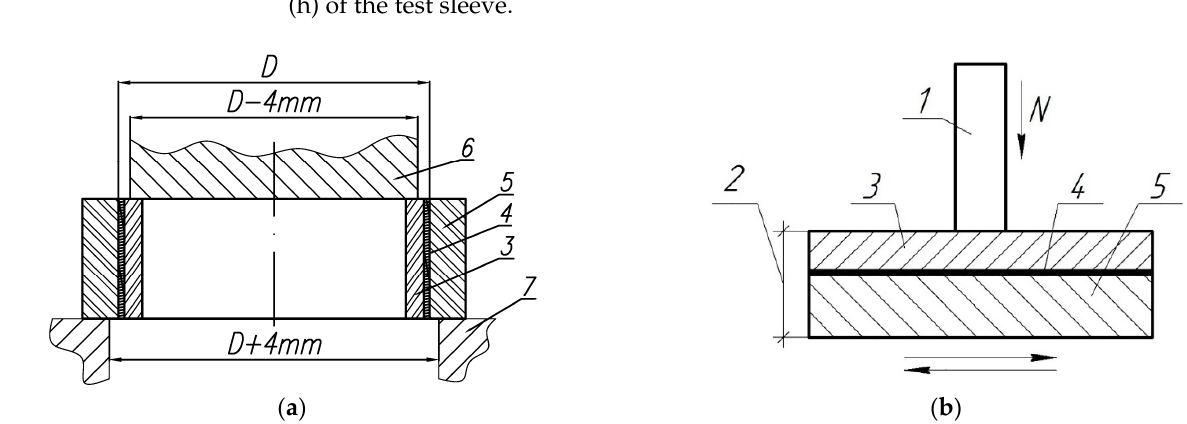
Figure 2. The schemes of adhesive ( a ) and tribological ( b ) testing of the samples: N—load; 1—counterbody; 2—sample; 3—AlSi12 alloy coating; 4—transition layer; 5—steel base; 6—punch; 7—matrix form.